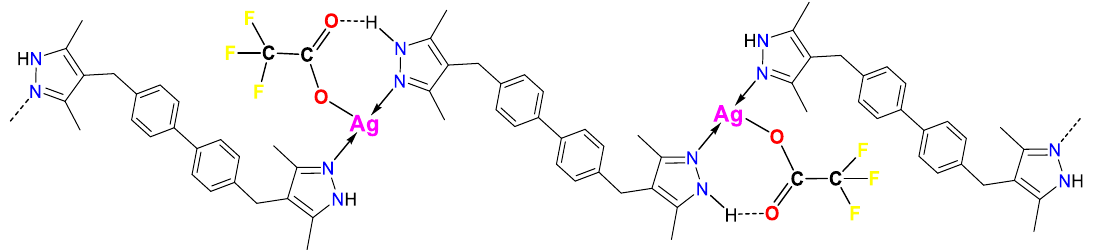
Figure 5. Proposed polymeric structure of [Ag(H 2 DMPMB)(CF 3 CO 2 )] ( 2 ), evidencing the T-shaped stereochemistry of silver(I) ions assured by the trifluoroacetate anions and the neutral ligands coordinated in a bridging exo-bidentate mode.